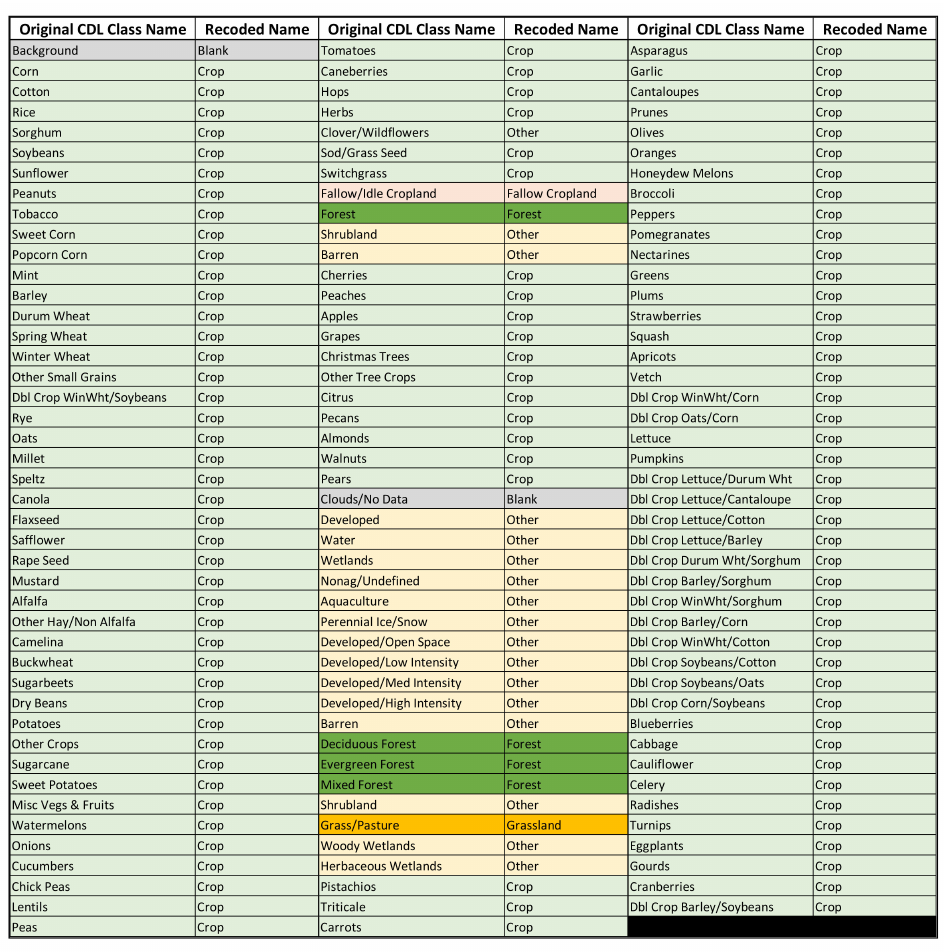
Figure A1. Crop classes in the Cropland Data Layer that were included in total cropland